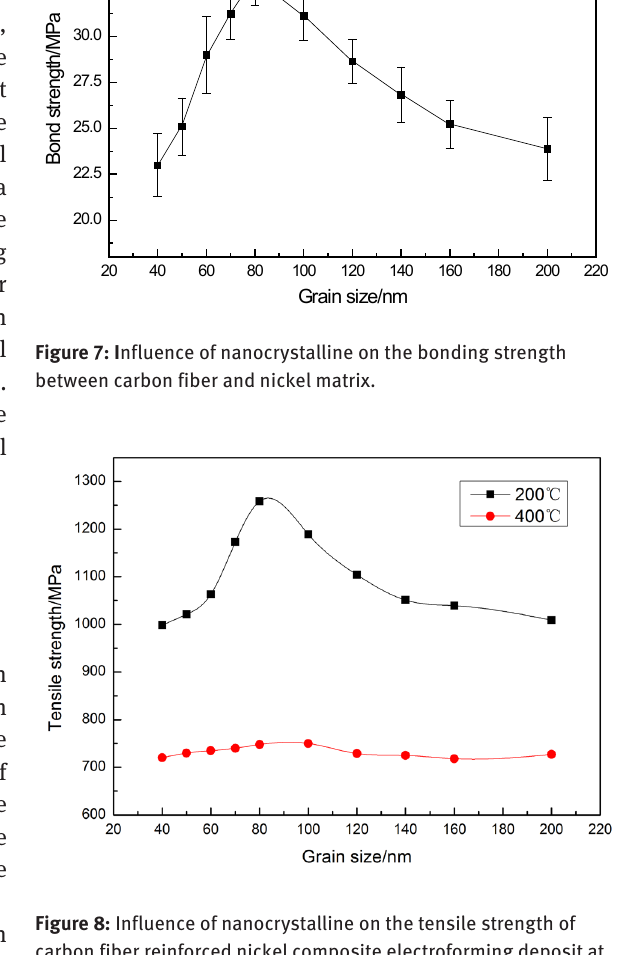
Figure 8: Influence of nanocrystalline on the tensile strength of carbon fiber reinforced nickel composite electroforming deposit at medium